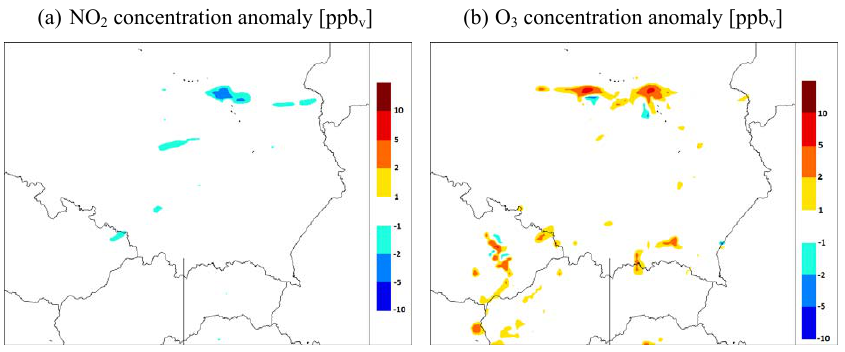
Figure 4. NO 2 (a) and O 3 (b) concentration anomalies calculated as a difference between urban and non-urban scenarios in the lowest model layer– 6 th of November 2010, 15 UTC